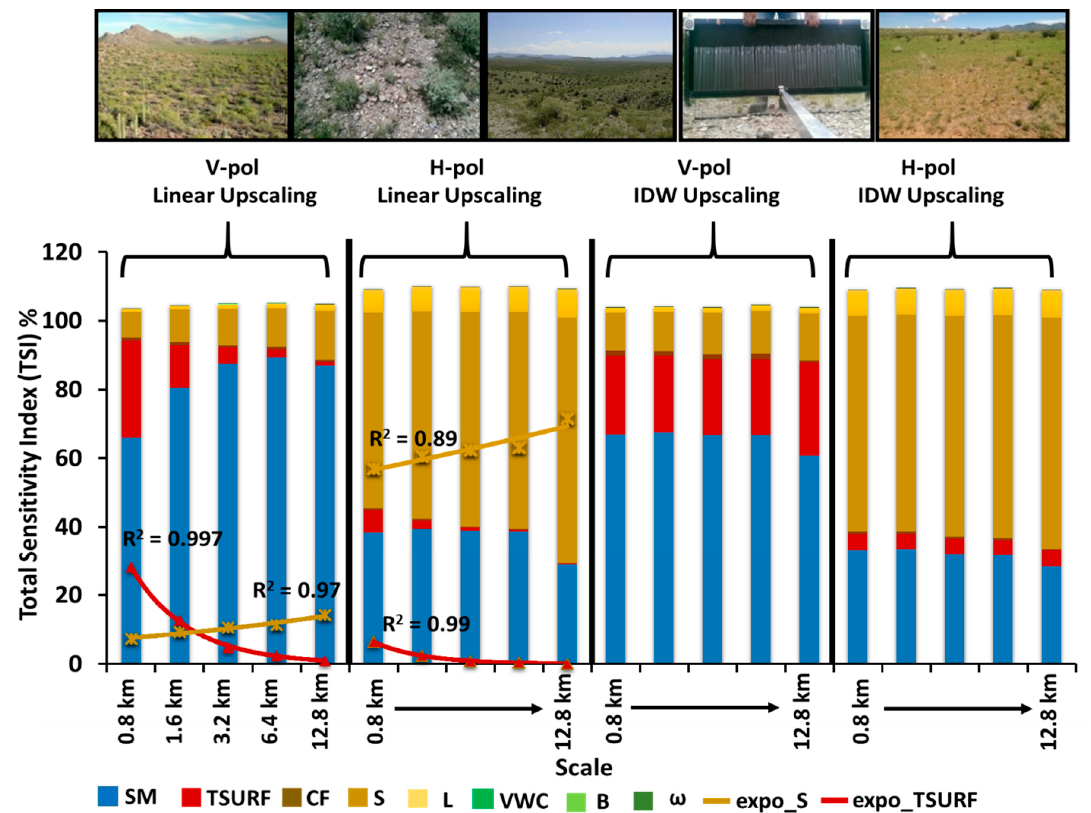
Figure 3. Soil Moisture Experiments 2004 (SMEX04), Total Sensitivity Index (TSI) for Brightness Temperature under V-polarization, and H-polarization using Inverse Distance Weighted (IDW) and Linear Upscaling. SM: Soil Moisture; CF: Clay Fraction; S: Root Mean Square Height; L: Correlation Length; TSURF: Surface Temperature; VWC: Vegetation Water Content; B: Vegetation Structure; ω : Single Scattering Albedo. The red and brown curves represent an exponential fit to TSURF (expo_TSURF, V-pol: R 2 = 0.997 & H-pol: R 2 = 0.99) and to S (expo_S, V-pol: R 2 = 0.97 & H-pol: R 2 = 0.89), respectively. The symbols represent the TSI values of the respective variables, while R 2 represents the goodness of fit.